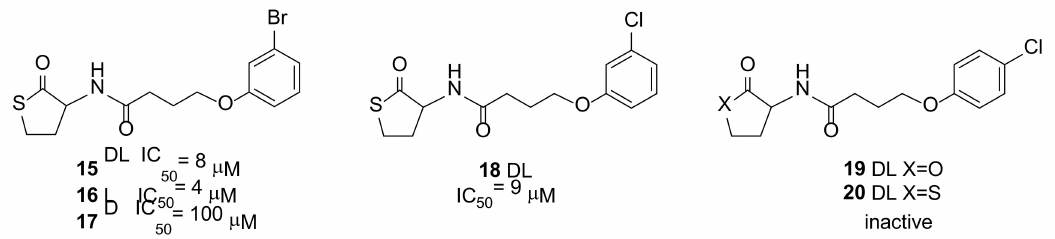
Figure 6. Thiolactone QS modulators of LuxR-type receptor from the Bassler’s group. In 2019, Blackwell and coworkers [41] reinvestigated their collection of acyl L -homocysteine thiolactones originally designed for targeting LuxR proteins, as non-native QS modulators of the activity of the RhlR receptor in P. aeruginosa . These compounds, more stable than lac- tones, proved to be very effective QS modulators (RhlR). The activities were also evaluated in the E. coli RhlR system. Compound 22 displayed agonistic activity in both P. aeruginosa and E. coli , but at 5-times lower concentration in P. aeruginosa compared to E. coli . These compounds exhibited high selectivity towards the RhlR receptor in P. aeruginosa relative to the QS LasR receptor (Figure 7).